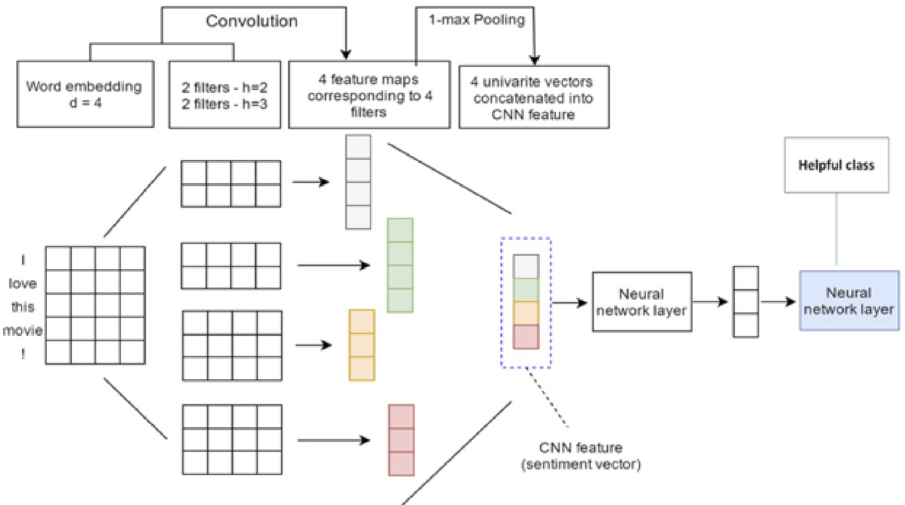
Fig. 4. The framework for helpful